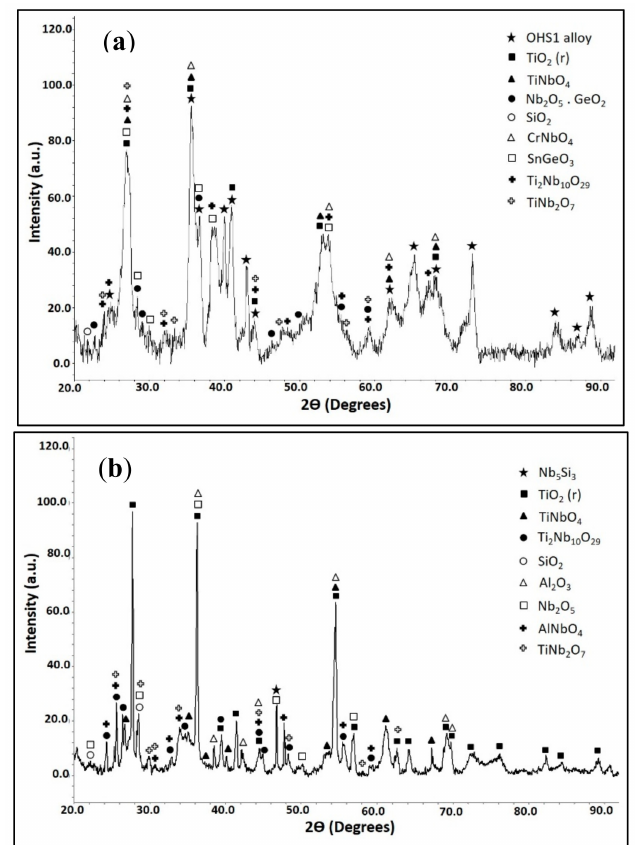
Figure 6. Glancing-angle XRD (GXRD) data of the scales formed on the alloy OHS1 at ( a ) 800 and ( b ) 1200 ◦ C in air, in ( a ) γ = 2 ◦ and ( b ) γ = 10 ◦ . ( a ) TiO 2 (JCPDS 21-1276), TiNbO 4 (JCPDS 81-911),